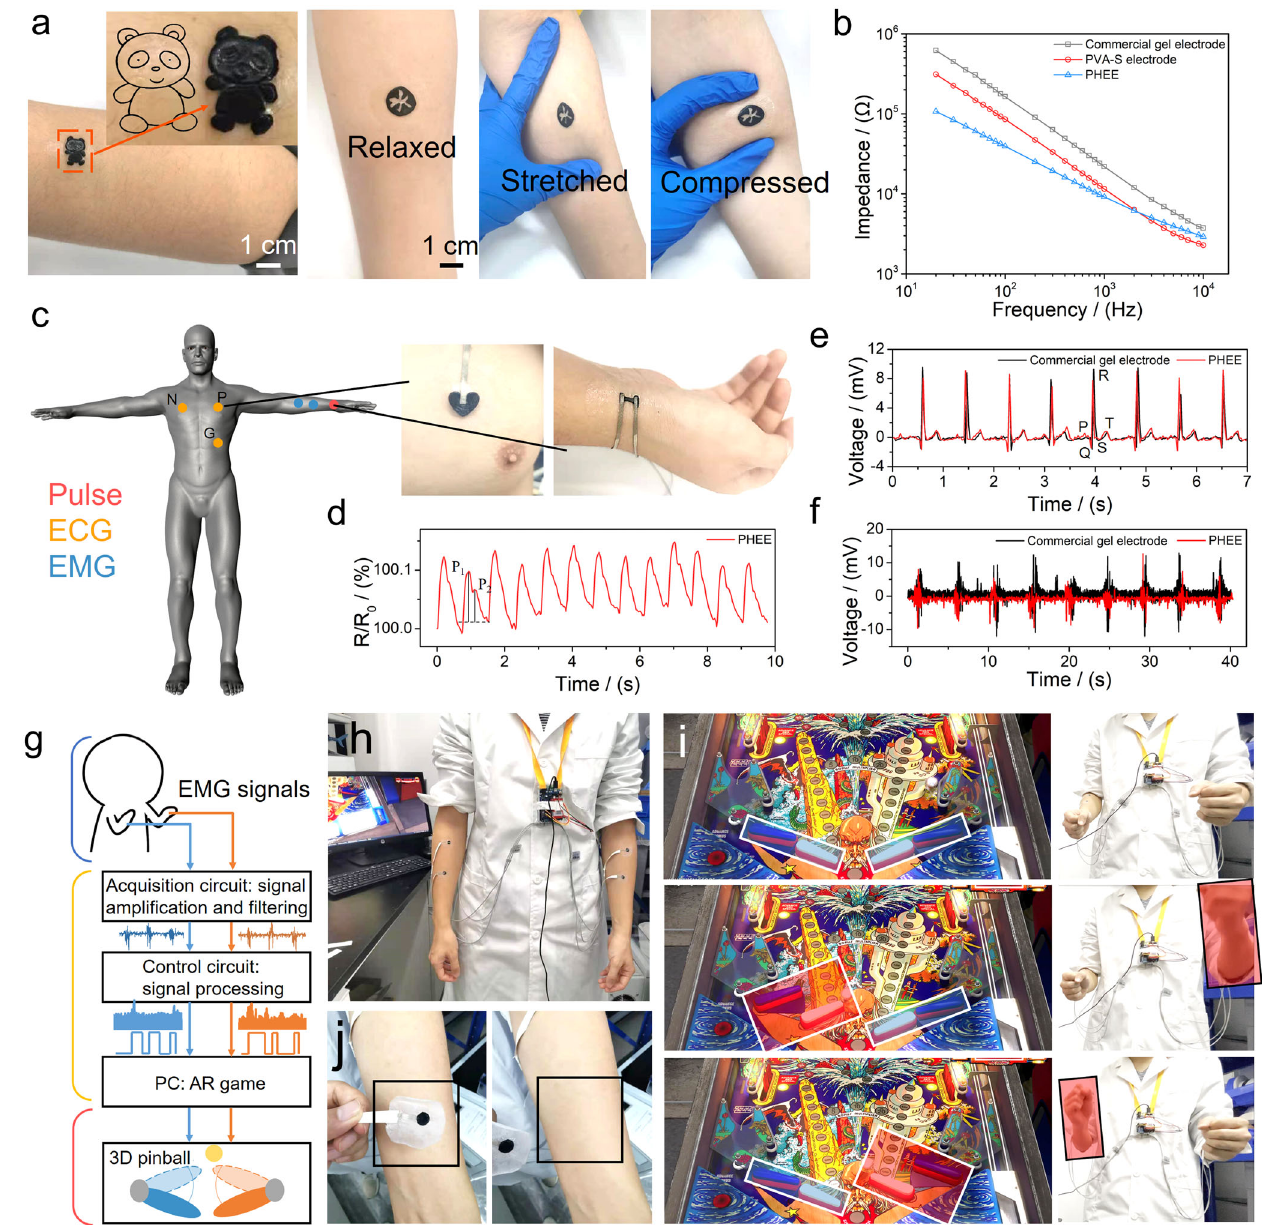
Fig. 5 Schematic illustrations and images of the skin-friendly PHEE for acquiring physiological states. a PHEE mounted on the skin and compressed and stretched by ~ 20%, respectively. b The impedance of the skin/electrode interface. AgCl gel commercial electrode with the same area used as reference. c Schematic illustration of electrode placement sites. d Continuous radial arterial pulse waveform measured on the wrist by the PHEE. e ECG response of PHEE compared to commercial gel device. f EMG signals measured using the PHEE and commercial gel electrodes, respectively. g Overview of the proposed AR control system. h Photographs of PHEEs attached to the forearms for AR triggered by the EMG signals. i Application in playing 3D pinball with motion sensing. The two pairs of PHEEs correspond to the left and right fl ippers, respectively. j The damage-free and eco-friendly detachment of PHEE after 1 h